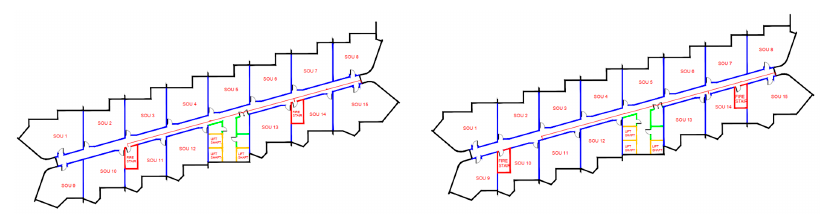
Figure 4. Case #3—Performance ( left ) and DTS ( right ) solutions.